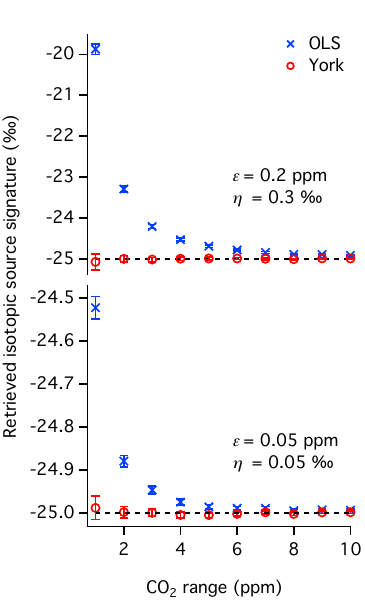
Figure 2. Mean isotopic signatures retrieved from ensembles of 5000 simulated Keeling plots (each containing 5000 points) using the York and OLS methods, for CO 2 ranges from 1 to 10ppm and a true isotopic signature of − 25‰. The standard deviations of the random noise added to the simulated measurements of c and δ are inset. Error bars show 2 standard errors. Note the differing scales for the